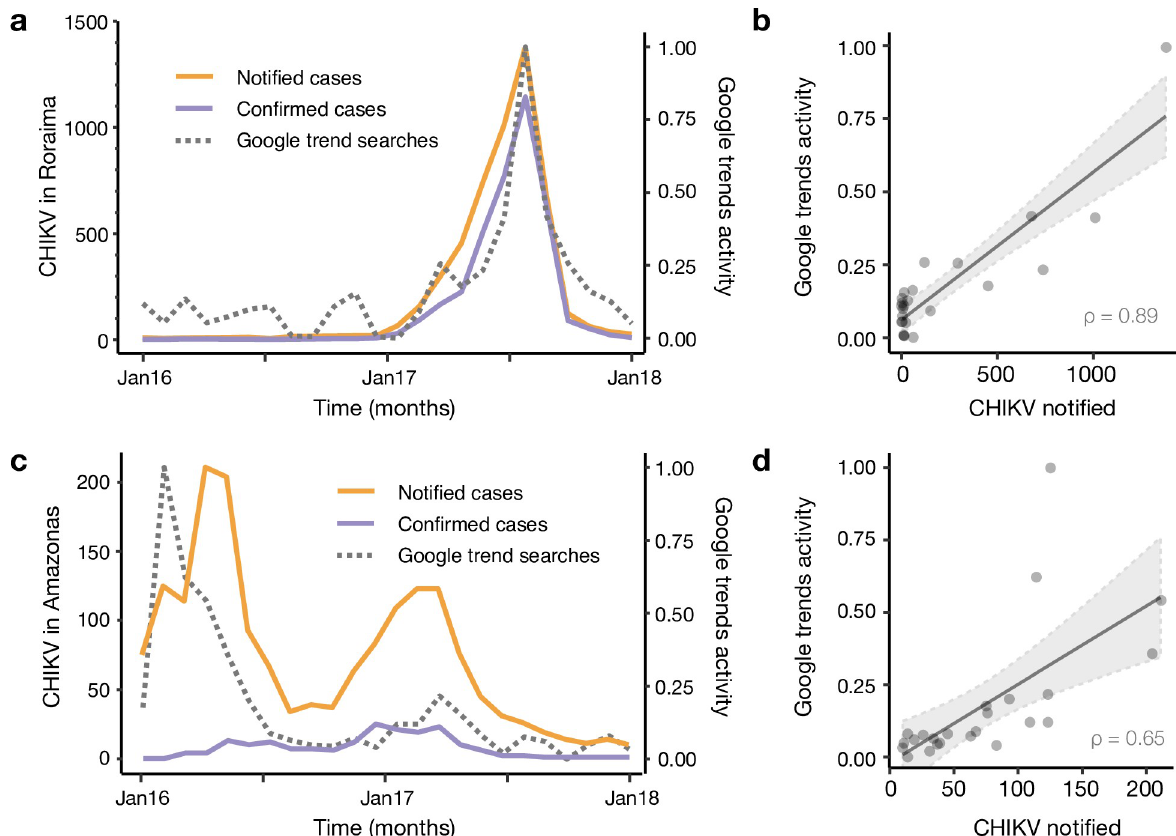
Fig 4. Digital surveillance of chikungunya in the Brazilian Brazil. Notified (orange) and confirmed (purple) cases in the central public health laboratories in Roraima state (a) and the Amazonas state (c) from January 2016 to January 2018. Dashed grey lines in (a) and (c) represent Google Trends activity for the term “chikungunya” in Roraima and Amazonas, respectively. Panels b and d show the correlation between Google Trends activity and cases notified in Roraima and Amazonas, respectively. Strength of the association was measured using the Spearman’s rank correlation coefficient (in panel b: p-value < 0.001; panel d: p-value =